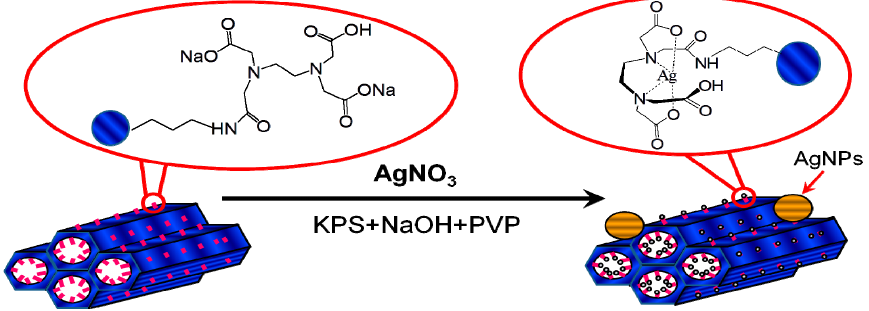
Figure 9. Schematic for the tentative mechanism of high valence Ag formed on the surface of SBA-15.